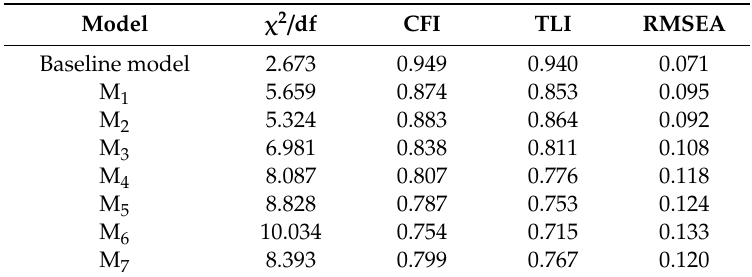
Table 2. Comparison of measurement